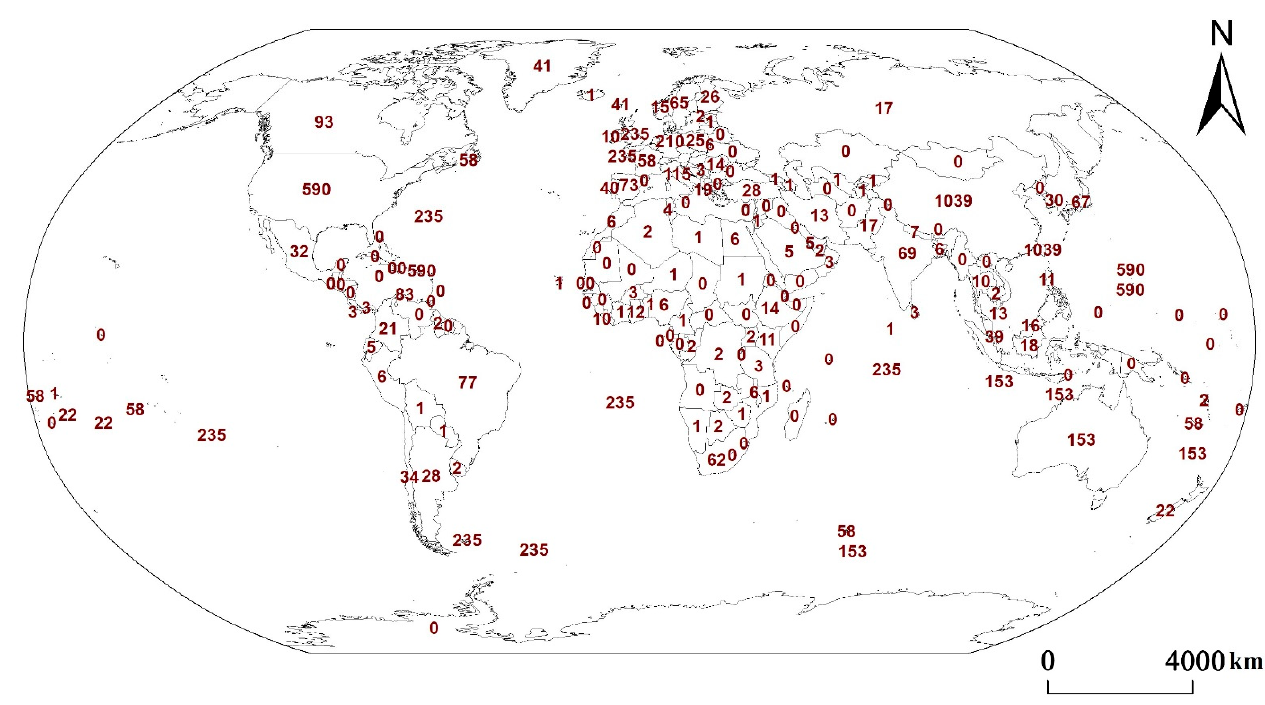
Figure 4. Quantity distribution of international ecosystem services papers. The numbers in the figure are the number of research papers in each region.